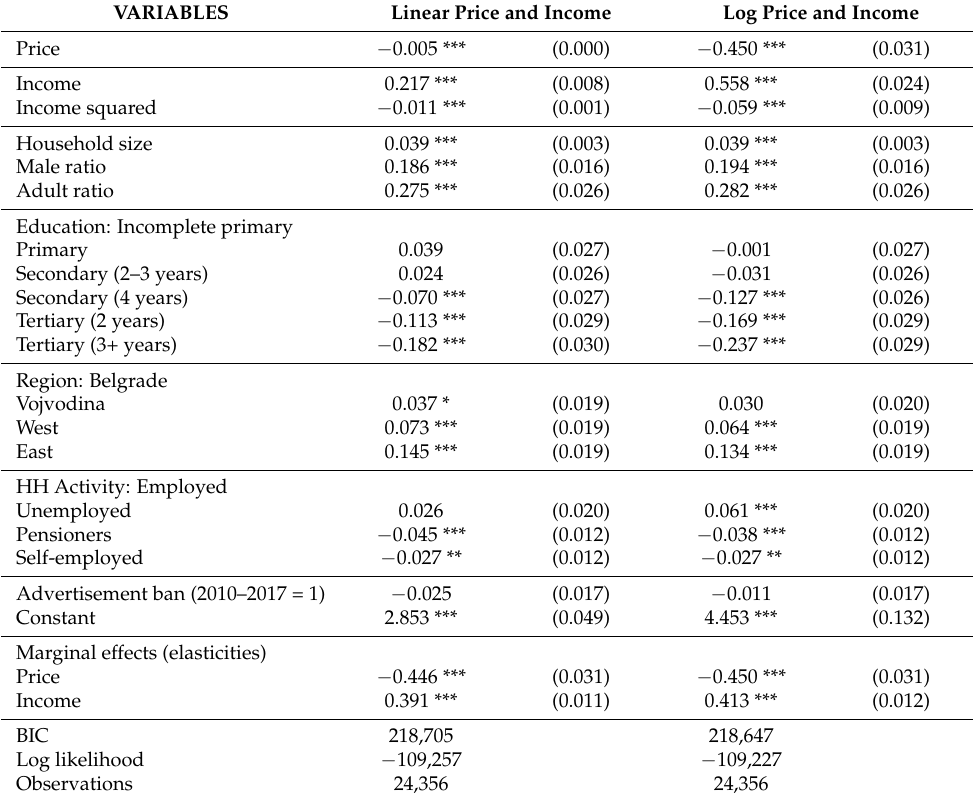
Table A3. Conditional demand model (GLM